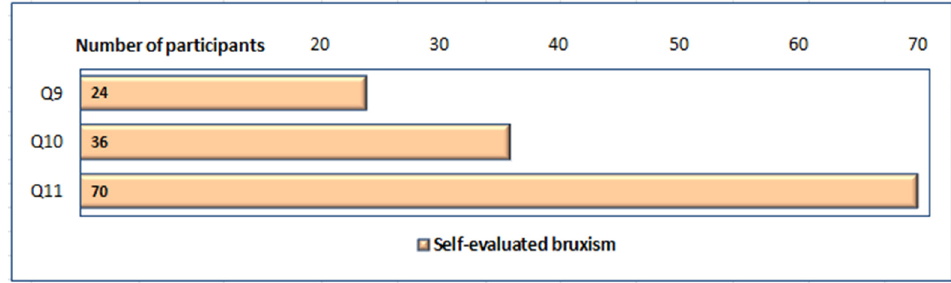
Figure 2. Distribution of participants groups presenting clinical signs of AB: muscular fatigue dur- ing the day, associated with the functions of the MS [Q9], grinding [Q10] and clenching [Q11] during daytime.